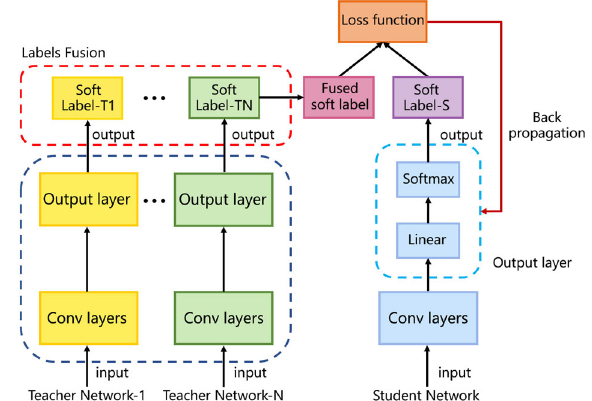
Fig. 7 Knowledge distillation consisting of multiple teacher networks and a target student network. The knowledge is transferred from the teacher networks to the student network using a loss